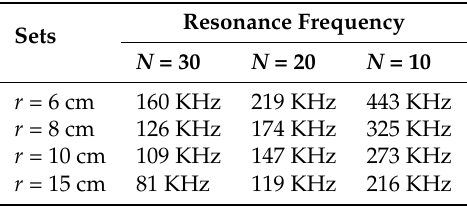
Figure 4. Experimental setup for MI waveguide based communication system, ( a ) schematic representation, and ( b ) lab setup. Table 1. Resonance frequencies for four different set of